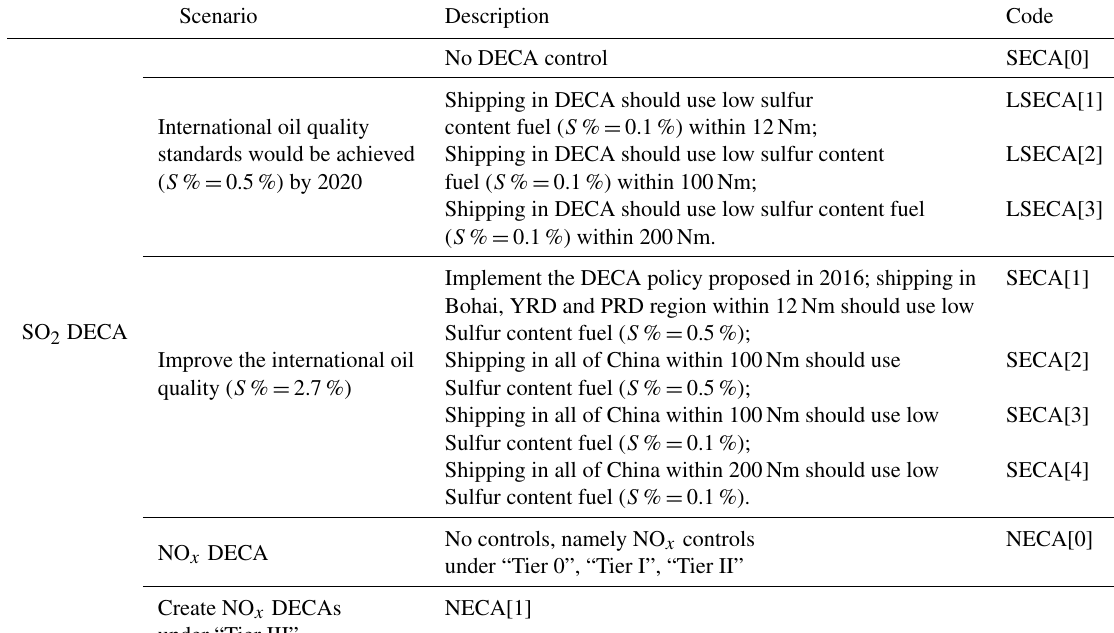
Table 5. Ship emissions reduction analysis scenarios of SO 2 DECA and NO x